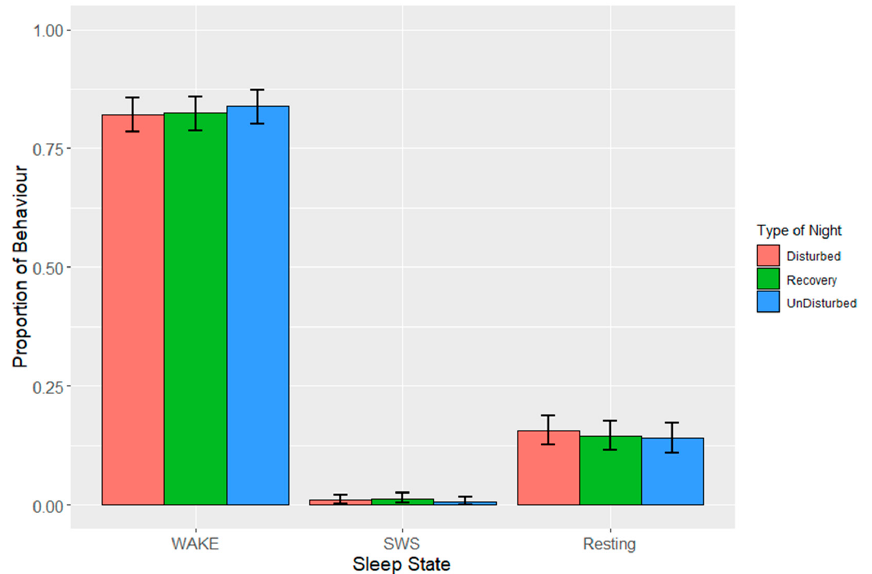
Figure 7. E ff ects during lights on following the three di ff erent types of night on proportions of states (wakefulness (WAKE), slow-wave sleep (SWS) and resting). Values are back-transformed means ± SEs estimated from LMMs fi tt ed to angular transformed proportions.